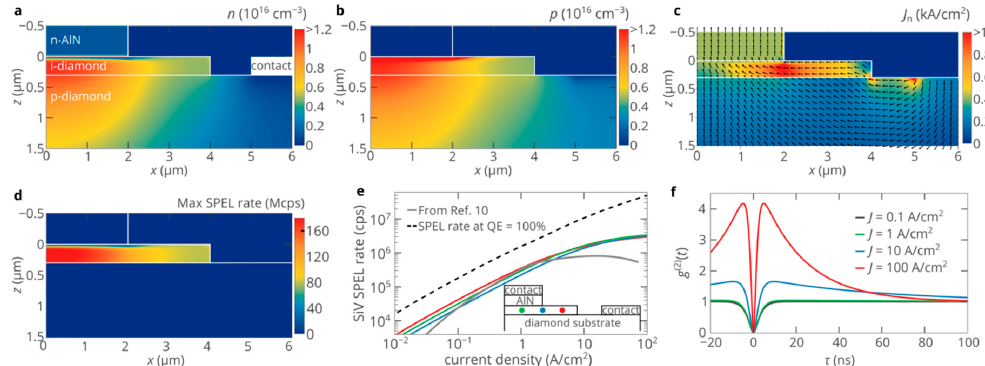
Figure 4. ( a – c ) Distributions of the electron density ( a ), hole density (b) and electron current density ( c ) in the SPED shown in Figure 3a at a bias voltage of 6.5 V. ( d ) Dependence of the single-photon electroluminescence (SPEL) rate of the SiV center on its position in the i-type diamond region of the SPED shown in Figure 3a. ( e ) Dependence of the SPEL rate of SiV center on the injection current for three different positions of the center in the i-region shown in the insert. The grey curve shows the dependence of the maximum SPEL rate of the SiV center in a diamond p-i-n diode from Reference [10]. The dashed line shows the SPEL rate at 100% quantum efficiency of the SiV center and the lifetime of the excited state of ~1 ns. ( f ) g (2) function for the SiV center located at x = 1 μ m, z = 150 nm for different pumping levels. The lifetime of the excited state is 1.2 ns, the lifetime of the shelving state is 100 ns [36] and the quantum efficiency is equal to 30% [33].